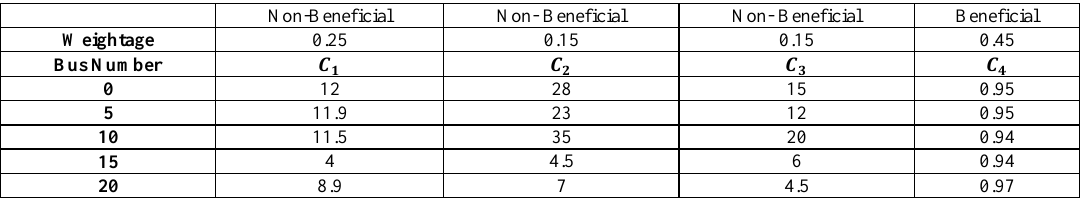
Table 2. Decision matrix (certain